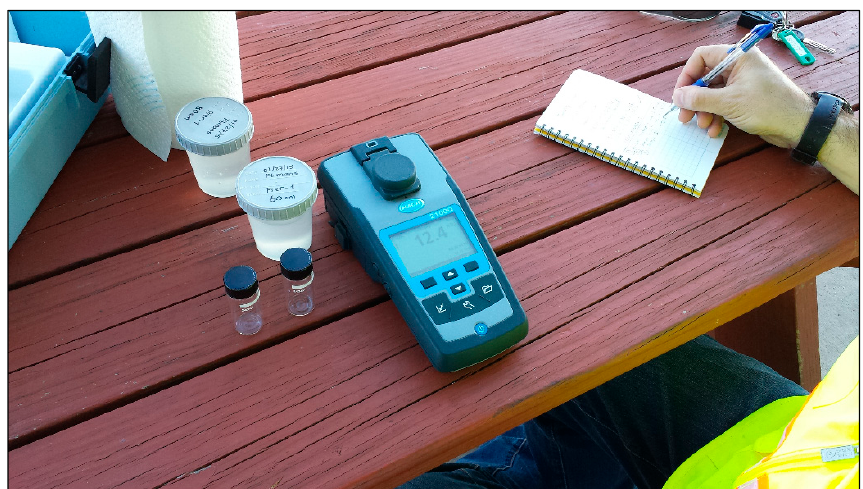
Figure 10. Hach 2100Q field turbidimeter.